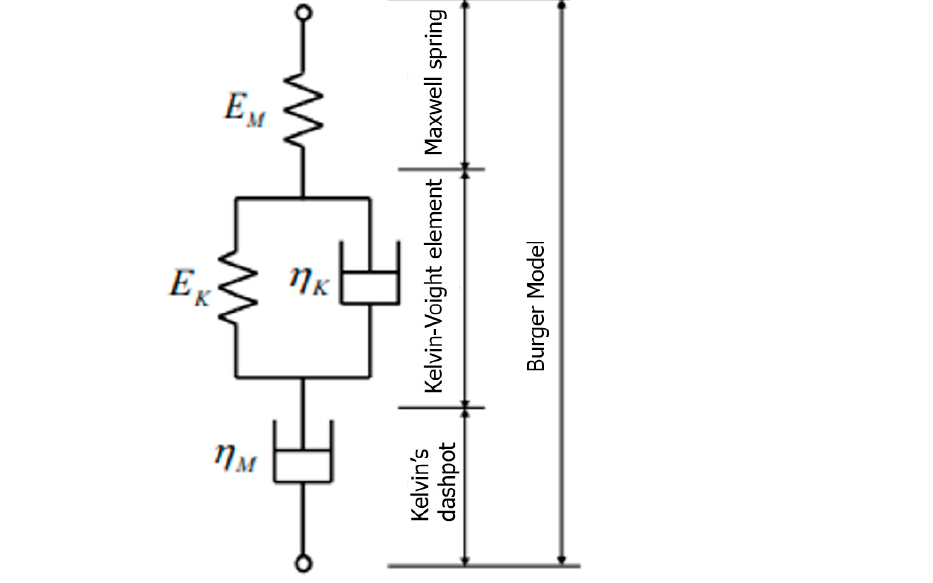
Figure 11. The Burger model comprises a Maxwell spring, Dashpot element, and Kelvin–Voight element [24]. Reproduced with copyright permission from Creative Commons Attribution License 3.0.